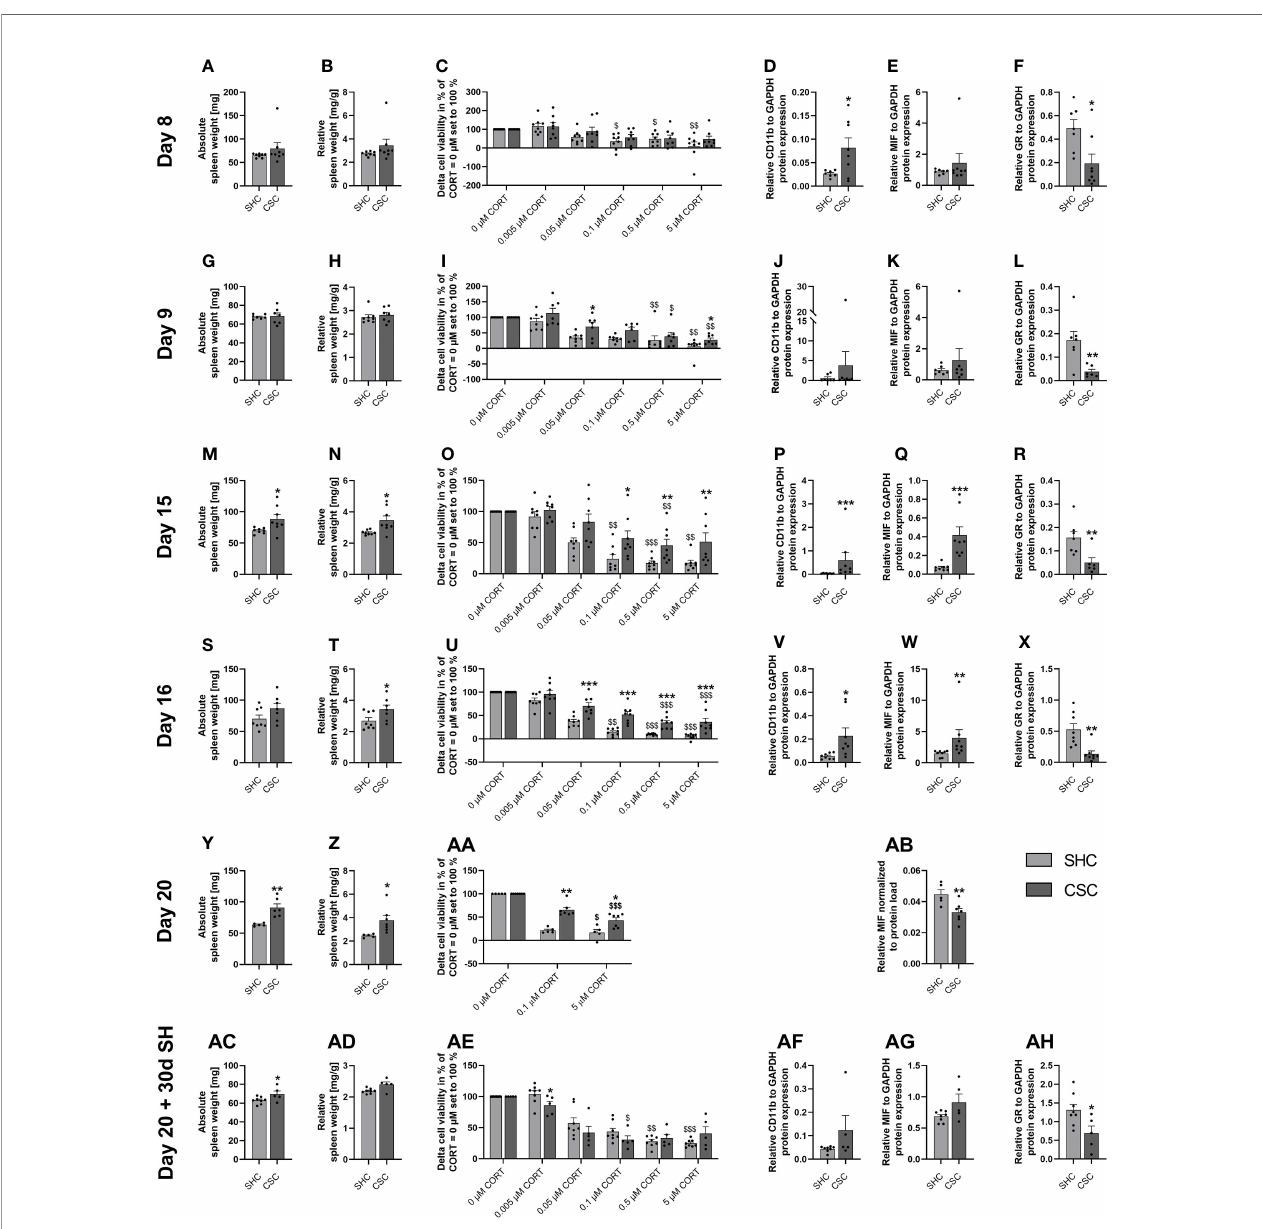
FIGURE 2 | Days 8, 9, 15, 16, 20 of the chronic subordinate colony housing (CSC) paradigm or single housed control (SHC) condition and one month following termination of the CSC paradigm – effects on the spleen. (A, G, M, S, Y, AC) Absolute spleen weight. (B, H, N, T, Z, AD) Relative spleen weight. (C, I, O, U, AA, AE) Delta cell viability (Lipopolysaccharide (LPS)-stimulated minus basal conditions) of isolated and in vitro stimulated splenocytes with different concentrations of corticosterone (CORT; CORT = 0 µM set to 100%). (D, J, P, V, AF) Relative CD11b protein expression, (E, K, Q, W, AB, AG) relative macrophage migration inhibitory factor (MIF) protein expression and (F, L, R, X, AH) relative glucocorticoid receptor (GR) protein expression on day 8 (A – F) , day 9 (G – L) , day 15 (M – R) , day 16 (S – X) and day 20 (Y – AB) of the CSC paradigm and one month following termination of the CSC paradigm (AC – AH) . Data are presented as mean + SEM including individual values. * P ≤ 0.05, ** P ≤ 0.01, *** P ≤ 0.001 versus respective SHC; $ P ≤ 0.05, $$ P ≤ 0.01, $$$ P ≤ 0.001 versus respective 0 µM CORT condition. GAPDH, glyceraldehyde 3-phosphate dehydrogenase; SH, single